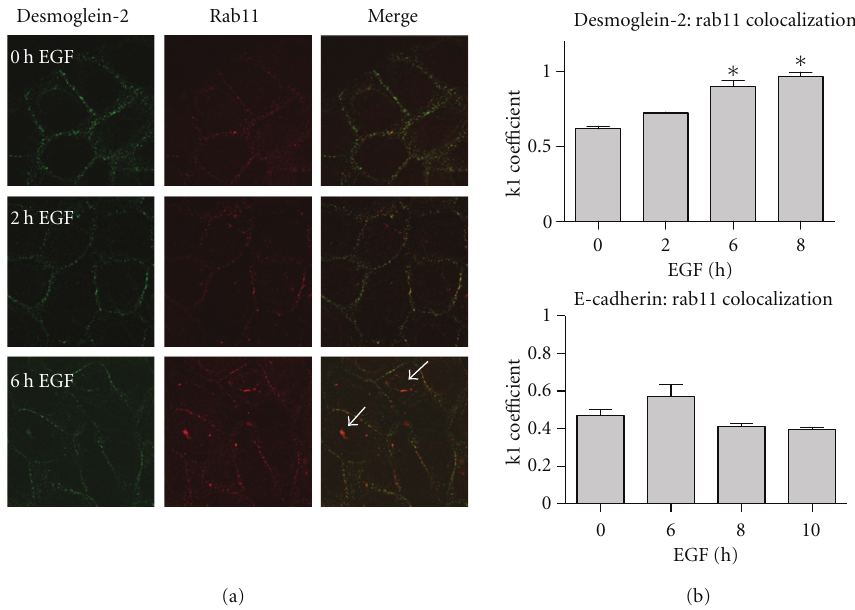
Figure 7: Desmoglein-2 colocalizes with Rab11, a recycling marker. (a) SCC 12F cells were treated for the indicated times with 20 nM EGF, then fixed with 3.7% formaldehyde and permeabilized with 0.1% Triton X-100. Cells were stained with antibodies against both desmoglein-2 and rab11. Secondary antibodies tagged with either FITC or Rhodamine were used. Colocalization is detected by the appearance of yellow staining where the red and green overlap, particularly in EGF-treated cells (white arrows). (b) Mandler’s overlap coe ffi cient, k1, measures the ratio of cadherin colocalized with Rab11 to total cadherin